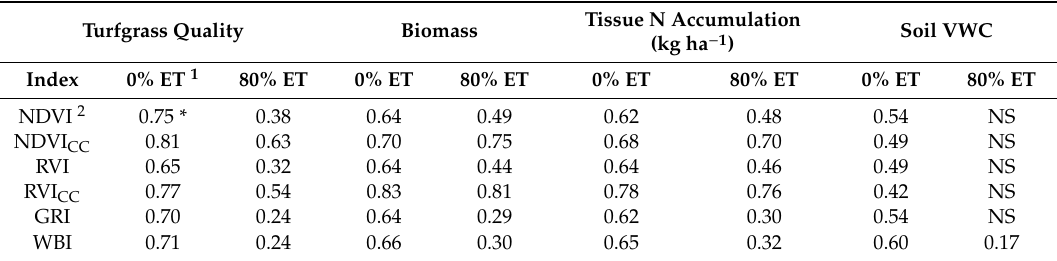
Table 6. Pearson correlation coe ffi cients ( r ) between turfgrass quality, tissue N content, tissue biomass, soil volumetric water content (VWC), and vegetation indices derived from spectral reflectance of tall fescue grown in Blacksburg, VA utilizing two irrigation